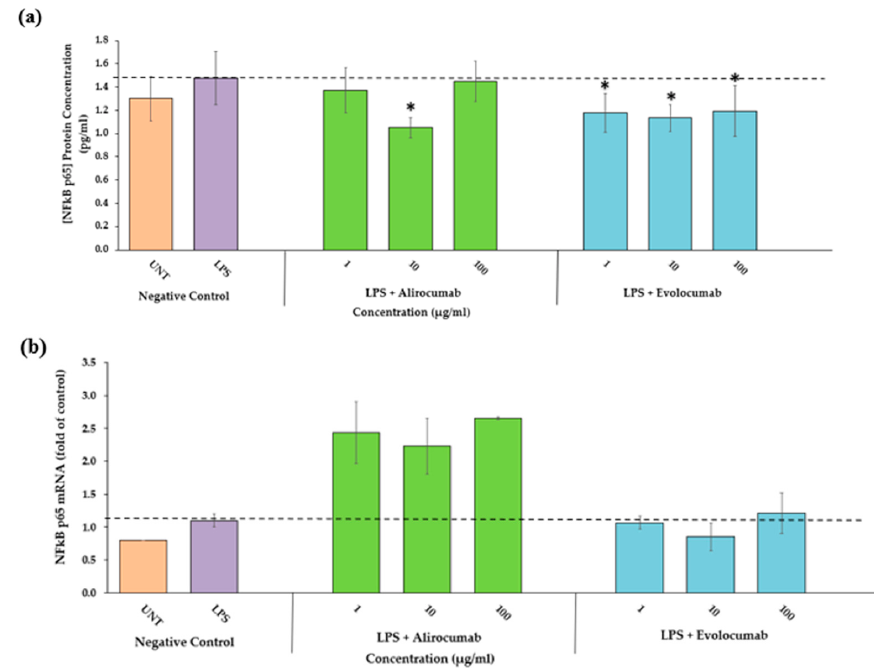
Figure 4. Effects of PCSK9 inhibitors on ( a ) NF- ĸ B p65 in nuclear lysate protein expression and ( b ) NF- ĸ B p65 gene expression in cell pellets in LPS-stimulated HCAEC. Data are expressed as mean ± SD